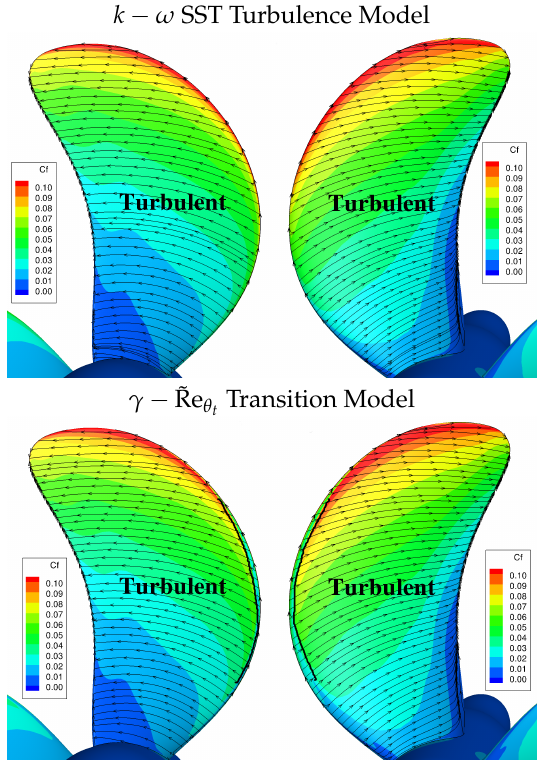
Figure 19. Limiting streamlines and skin friction coefficient using the k − ω SST turbulence model ( top ) and γ − ˜Re θ transition model ( bottom ) at Re = 1 × 10 7 for J = 0.568. Pressure side ( left ) and t suction side ( right